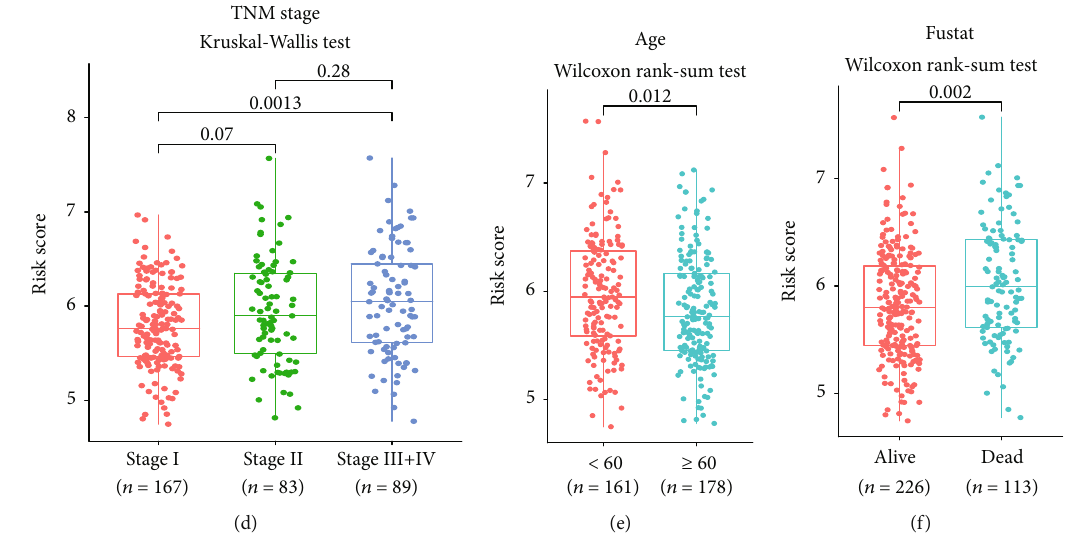
Figure 6: Associations between the RS and clinicopathological characteristics. (a) Strip chart of the clinicopathological characteristics in HCC patients; chi-squared test, ∗ P < 0 : 05 , ∗∗ P < 0 : 01 , and ∗∗∗ P < 0 : 001 . (b – d) Association between risk score and grade (b), T stage (c), and TNM stage (d); Kruskal-Wallis test, P values indicated. (e) Association between risk score and age; Wilcoxon rank-sum test, P = 0 : 012 . (f) Association between risk score and survival status; Wilcoxon rank-sum test, P = 0 : 002